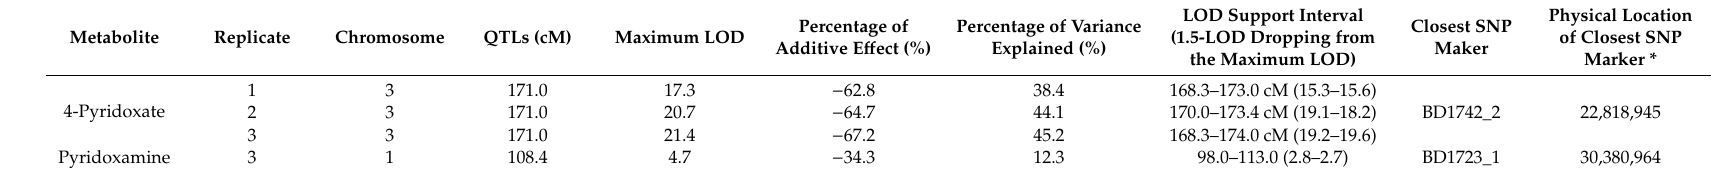
Table 1. Summary of mQTLs related to vitamin B6 metabolism.